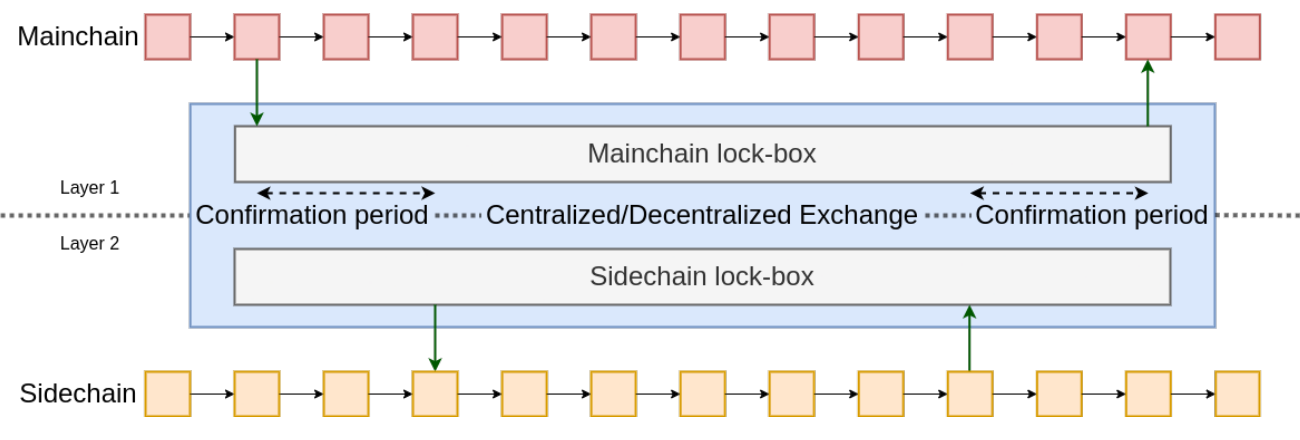
Figure 1. Illustration of a two-way-peg